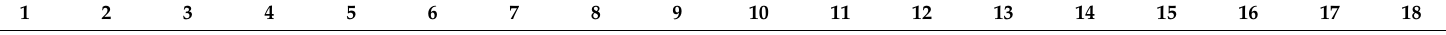
Table 2. Correlations of the measuring